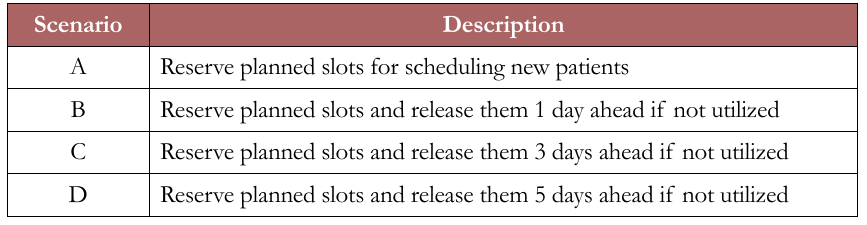
Table 7. Scenarios investigated for holding planned slots for new patients